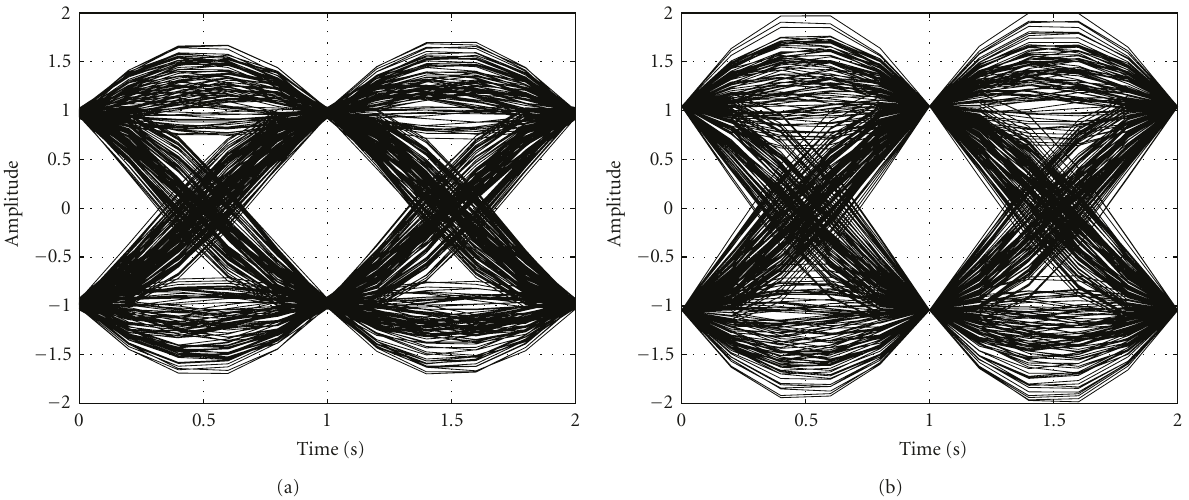
Figure 12: Eye diagrams of the transmitter and receiver cascade (a) B -filter; (b) Nyquist δ -filter, α = 0 . 284; G D = 12; N = 5; N O = 120.